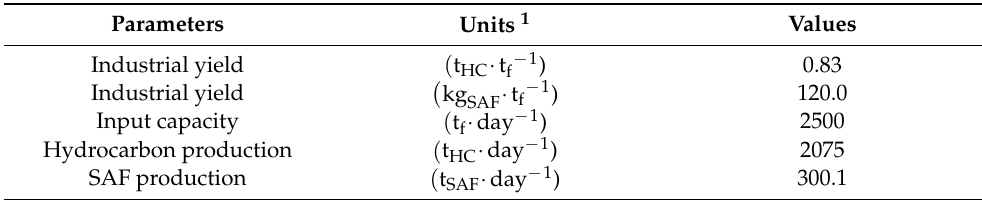
Table 2. Technical parameters for SAF production based on HEFA-SPK route, assumed in the case studies, based on Walter